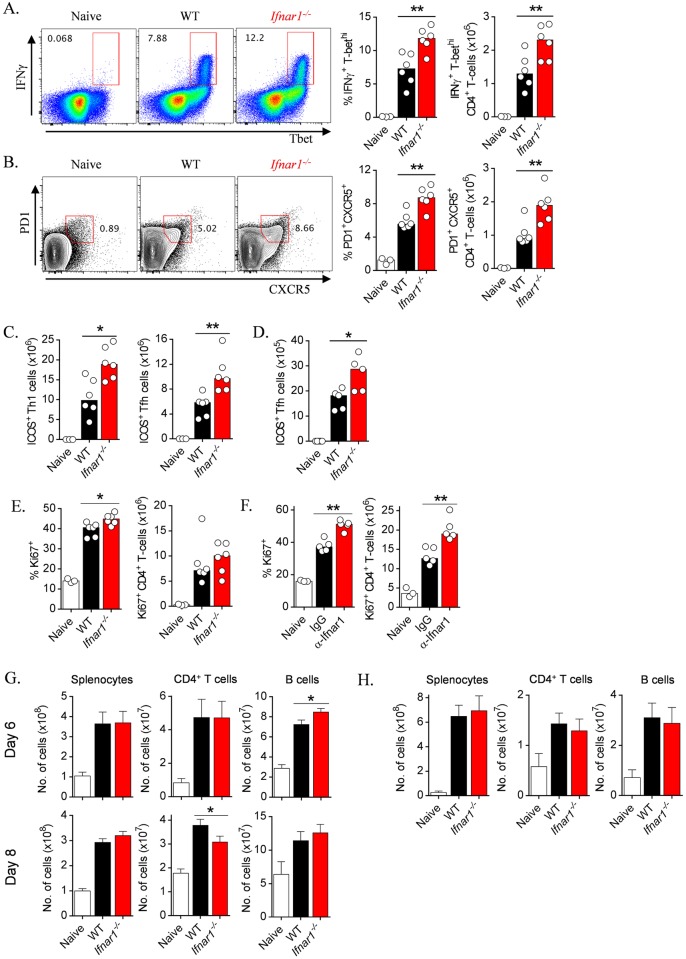
IFNAR1-signalling simultaneously limits splenic Th1 and Tfh cell responses.(A & B) Representative FACS plots (gated on CD4+ TCRβ+ live singlets), proportions and absolute numbers of splenic (A) Th1 (IFNγ+ Tbet+) and (B) emerging Tfh (PD1+ CXCR5+) cells in WT and Ifnar1
-/- mice (n = 6/group), 6 days p.i with PcAS. Data representative of two independent experiments. (C) Numbers of splenic ICOS+ Th1 cells (Tbet+ IFNγ+ CD4+ T cells) and Tfh cells (PD1+CXCR5+ CD4+ T cells) 6 days p.i. with PcAS. (D) Numbers of ICOS+ Tfh cells (PD1+CXCR5+ CD4+ T cells), 16 days p.i. with Py17XNL infection. (E) Proportions and absolute numbers of splenic CD4+ T-cells expressing Ki-67 in naïve, WT and Ifnar1
-/- mice 6 days p.i. with PcAS. (F) Proportions and absolute numbers of splenic CD4+ T-cells expressing Ki-67 in naïve mice, and WT mice, 6 days p.i. with Py17XNL and treatment with α-IFNAR1 or Control IgG. (G) Absolute numbers of splenocytes, CD4+ T-cells and B-cells, in WT naïve, infected WT and Ifnar1
-/- mice 6 days (n = 17–18, pooled from three independent experiments (n = 5–6 per expt)) and 8 days (n = 29, pooled from five experiments (n = 5–6 per expt)) p.i. with PcAS. (H) Absolute numbers of splenocytes, CD4+ T-cells and B-cells in WT naïve, infected WT and Ifnar1
-/- mice, 16 days p.i. with Py17XNL (n = 17–18, pooled from three experiments (n = 5–6 per expt)) Mann-Whitney U-test **P<0.01, *P<0.05.